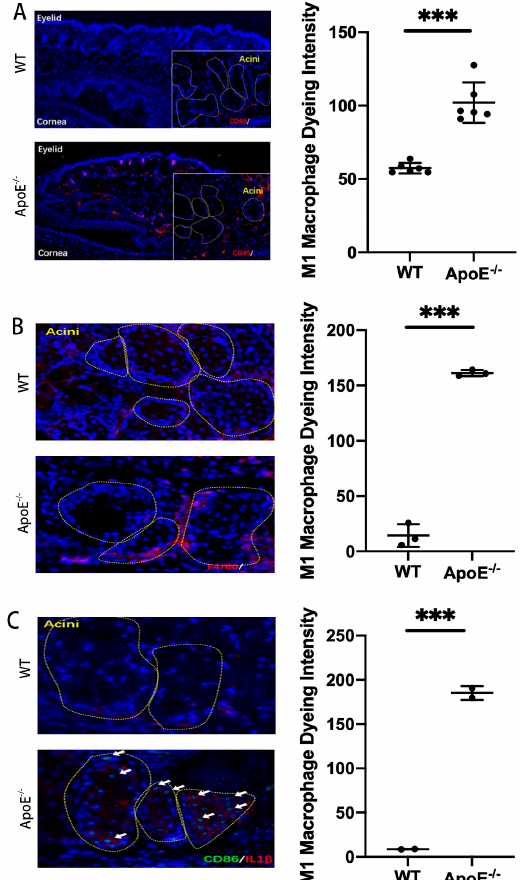
Figure 3. Immunofluorescence staining of macrophage markers in MGD mice. The acini of meibomian gland were signed by dashed boxes. ( A ) The results showed that the expression levels of CD45 (marker of M1 type) were significantly increased in ApoE -/- mice (MGD mice) than those in WT mice ( p < 0.0001 ). ( B ) The results showed that the expression levels of F4/80 (marker of M1 type) were significantly increased in ApoE -/- mice (MGD mice) compared to those in WT mice ( p < 0.0001 ). ( C ) The results showed that the expression levels of CD86 (marker of M1 type, signed by white arrows) were significantly increased in ApoE -/- mice (MGD mice) compared to those in WT mice ( p = 0.0010 ). No significant difference was found in the expression of IL1 β (marker of M1 type) between WT and ApoE -/- mice (*** p < 0.001).